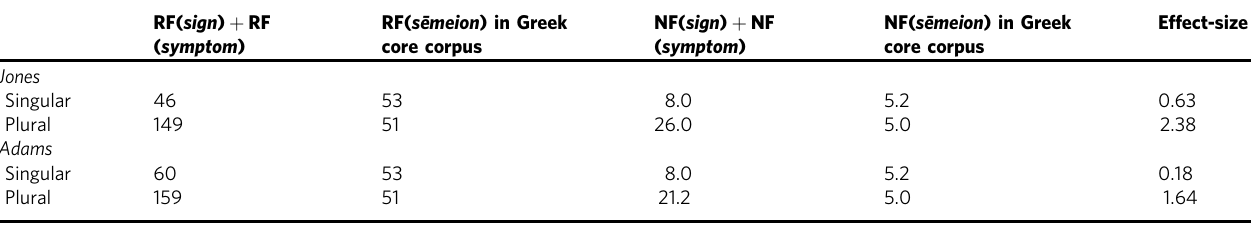
See Table 3 for effect-size